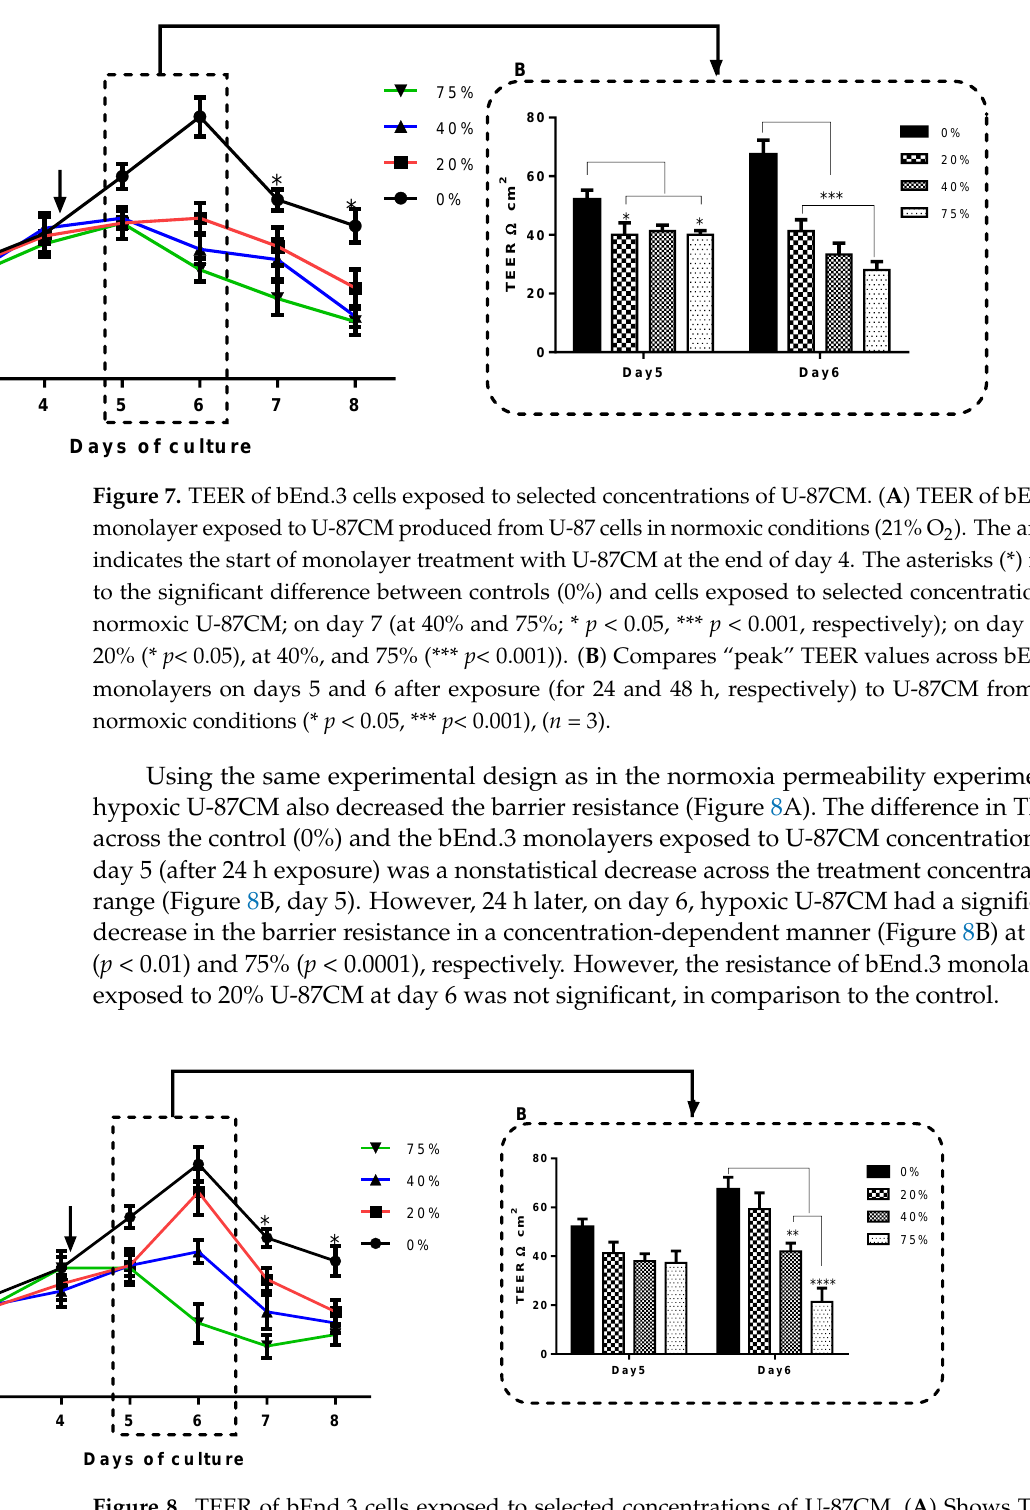
Figure 8. TEER of bEnd.3 cells exposed to selected concentrations of U-87CM. ( A ) Shows TEER of bEnd.3 monolayers exposed to hypoxic U-87CM. The arrow indicates the start of treatment of monolayers with U-87CM at the end of day 4. The asterisks (*) refer to the significant difference between controls (0%) and cells exposed to selected concentrations of hypoxic U-87CM; on day 7 (at 40% and 75%; ** p < 0.01, **** p < 0.0001, respectively) and on day 8 (at 20%, 40%, and 75%; * p < 0.05, ** p < 0.01, *** p < 0.001, respectively). ( B ) Compares “peak” TEER on day 5 (24 h exposure) and day 6 (48 h exposure) (** p < 0.01, **** p < 0.0001), ( n =